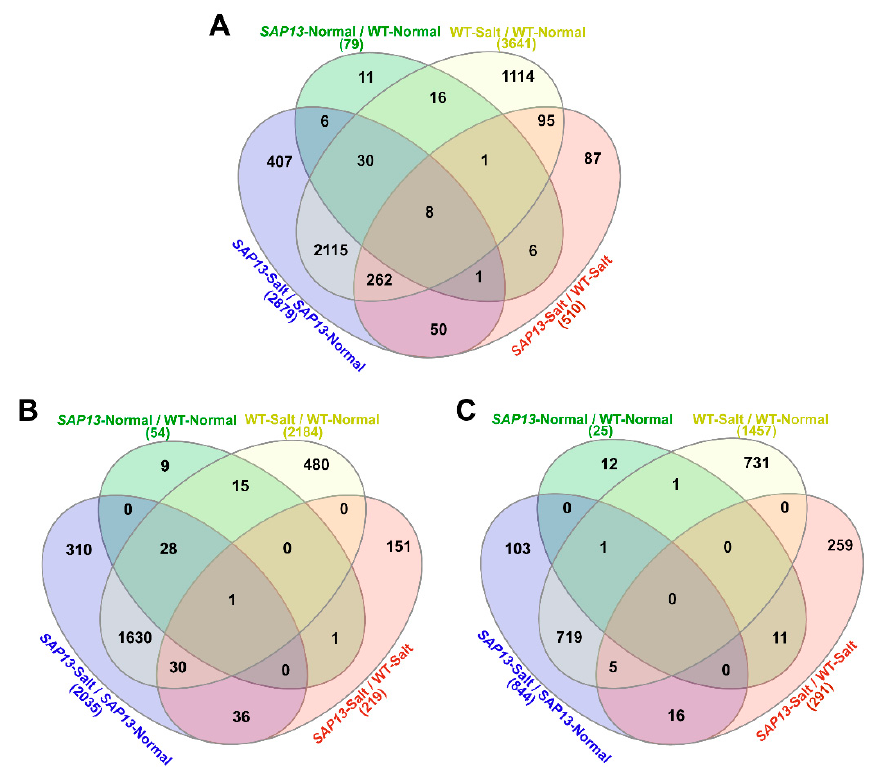
Figure 6. Venn diagram of the differentially expressed genes (DEGs) in four types of comparisons in WT and PtSAP13 -overexpressing plants under control (normal) and NaCl (salt) conditions. ( A ) Overlapping of DEGs. ( B ) Overlapping of up-regulated genes. ( C ) Overlapping of down-regulated genes. The numbers in brackets represent the total numbers of differentially expressed genes in different comparisons.